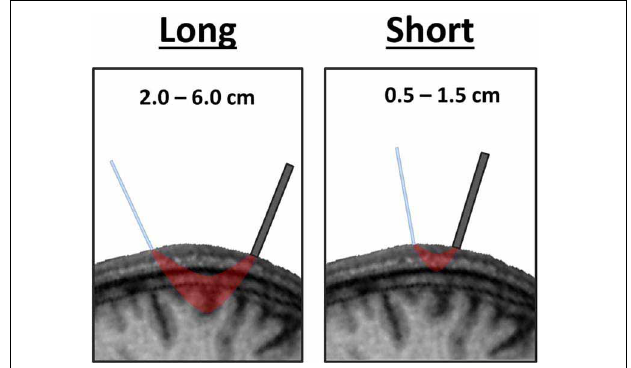
FIGURE 4 | Varying depth of penetration by near-infrared light between long and short distance channels. The path travelled by near-infrared light in a channel with long emitter-detector distances passes through cortical tissue whereas the path of light in a short channel travels only superficially through the scalp and